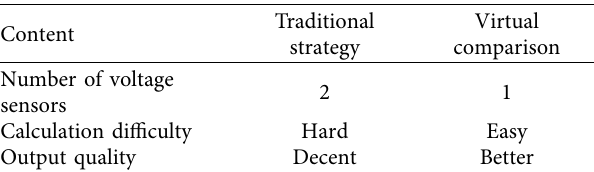
Figure 13: Structure of reference voltage calculation unit by using the strategy of virtual comparison. Table 2: Comparison of traditional compensation strategy and virtual